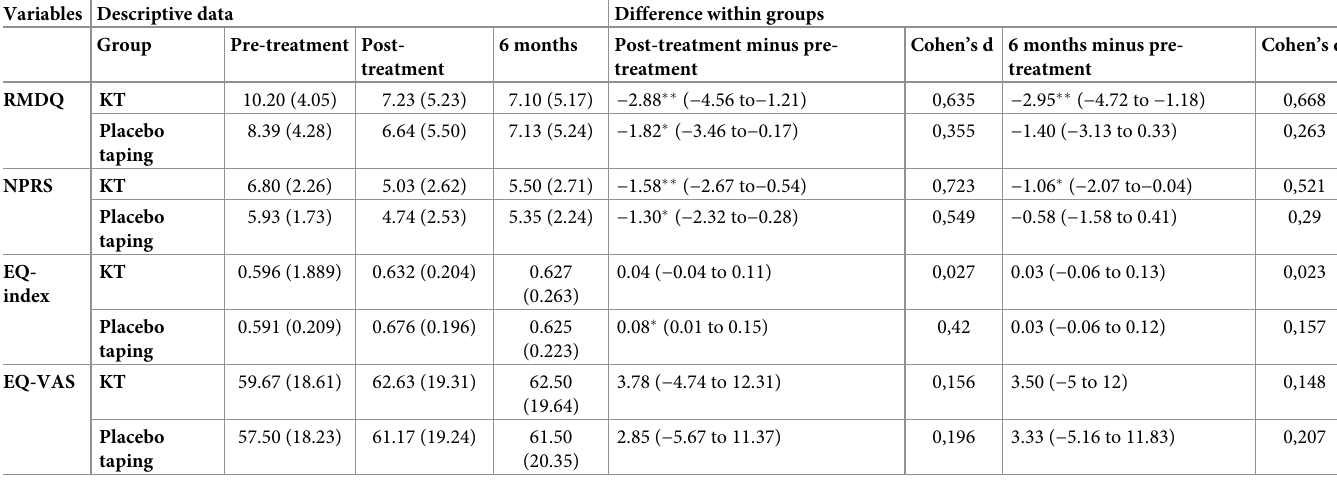
Table 2. Results of the variables (pre-treatment, post-treatment, and at 6 months) and difference within groups (post-treatment and at 6 months). Variables Descriptive